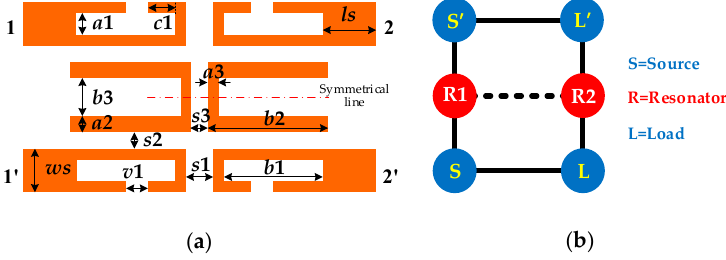
Figure 8. Configuration and coupling scheme of the proposed balanced filter: ( a ) Detailed configuration; ( b ) coupling scheme.